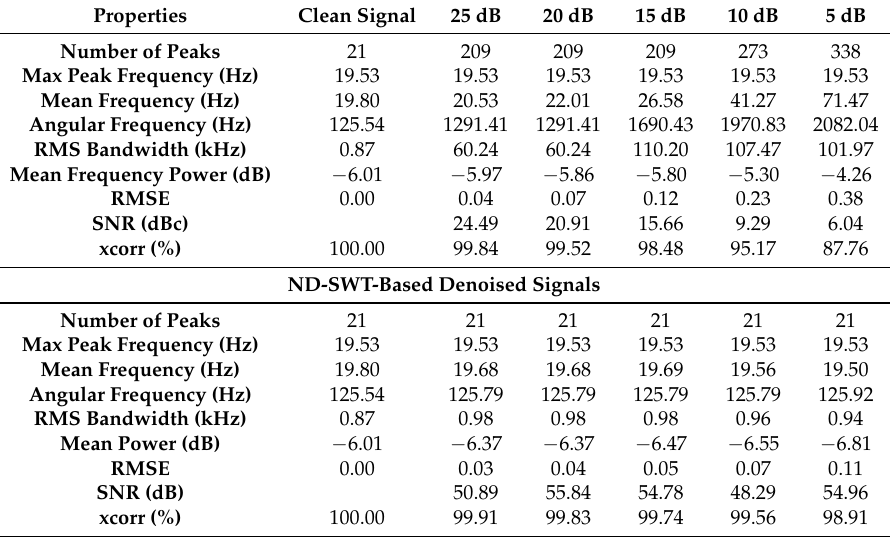
Table 3. Comparison among the properties of synthetic clean signal, different degrees of noisy signals and the ND-SWT-based denoised signals.